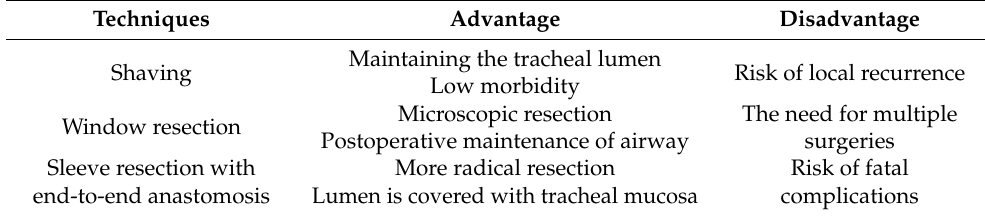
Table 1. Features of the surgical